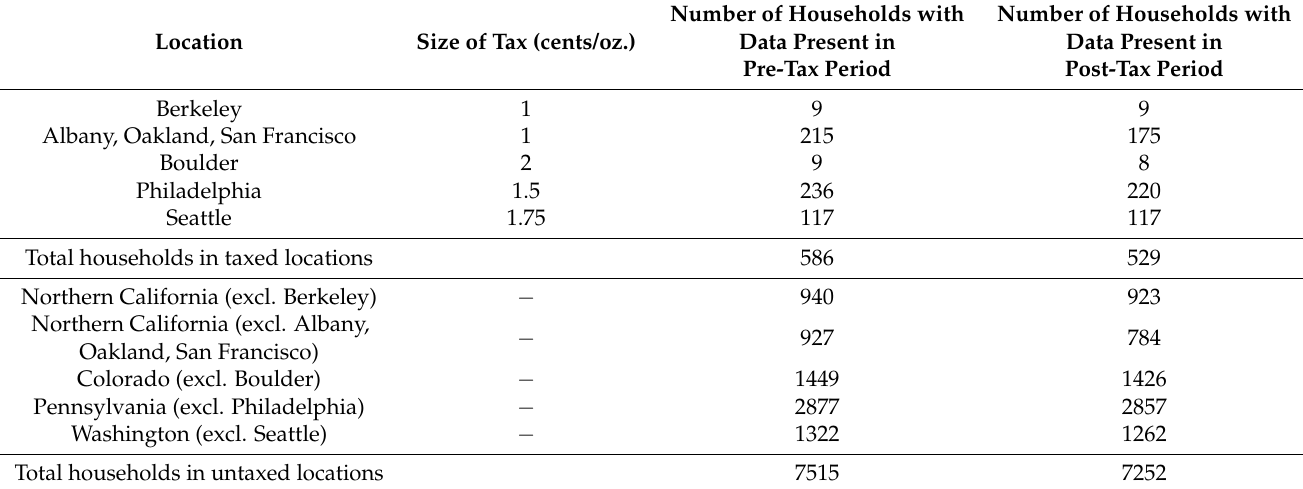
Table 1. Household Counts in Study